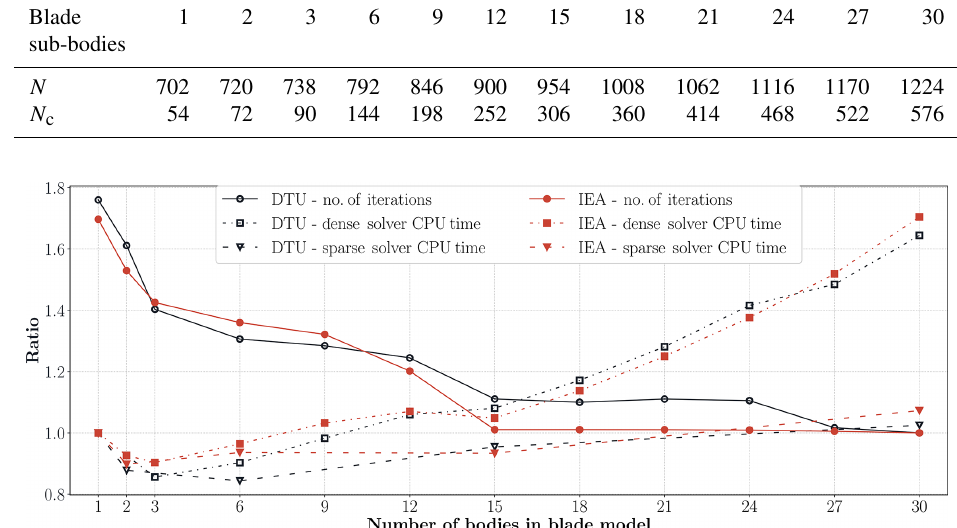
Figure 2. The total number of iterations is normalized by the result of the 30-sub-body case, and the total CPU time is normalized by the one sub-body dense matrix solver case for the DTU10MW and IEA10MW turbines. The CPU time ratios are given for both dense and sparse solvers.